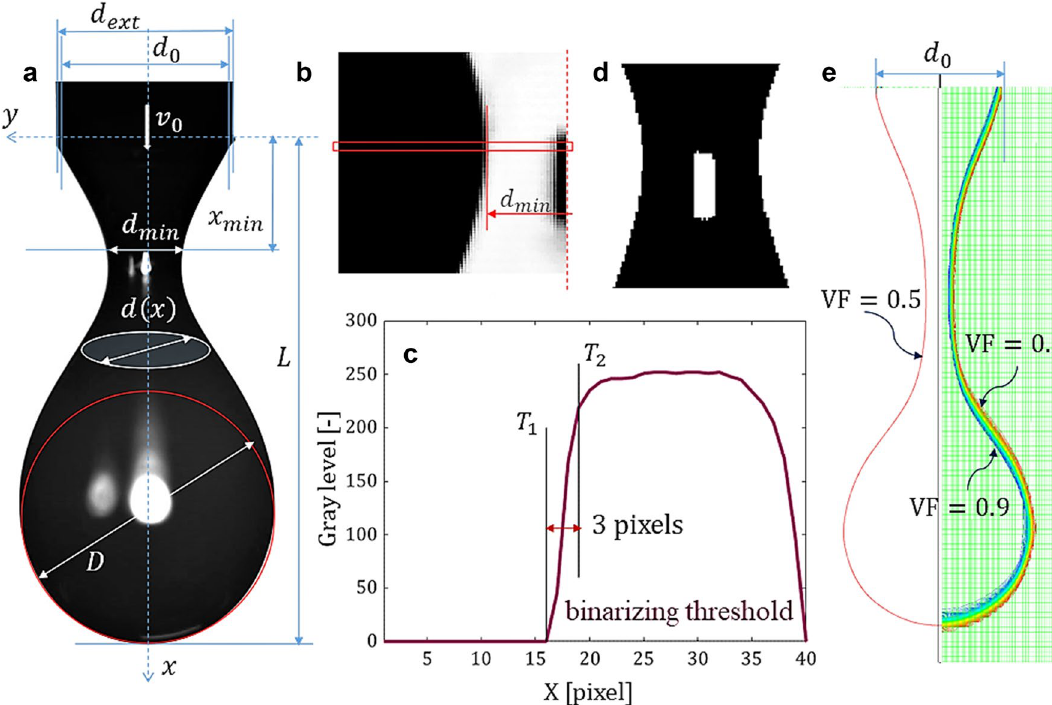
Figure 1. ( a ) Depiction of the investigated dimensions of a detaching droplet (silicone oil sample). Steps of the original imagine processing; detail of the neck diameter d ( x ) gray levels on the inspection line, corresponding to the minimum thickness of the filament, ( d ) final binarized image. Numerical interface ( e ); the mesh/cell size is 27.5 μm and the VF line VF = 0.5 approximates the computed interface with a maximum error of 42